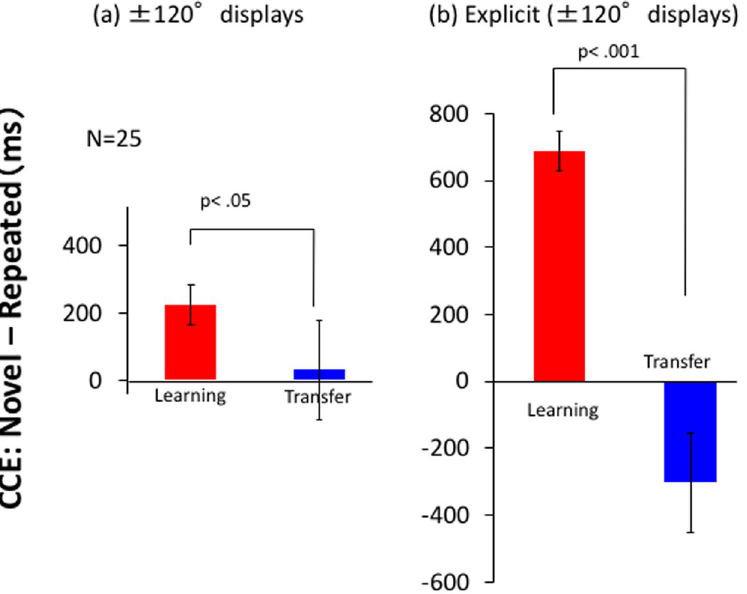
layout. ( b ) The t-test result is shown for each